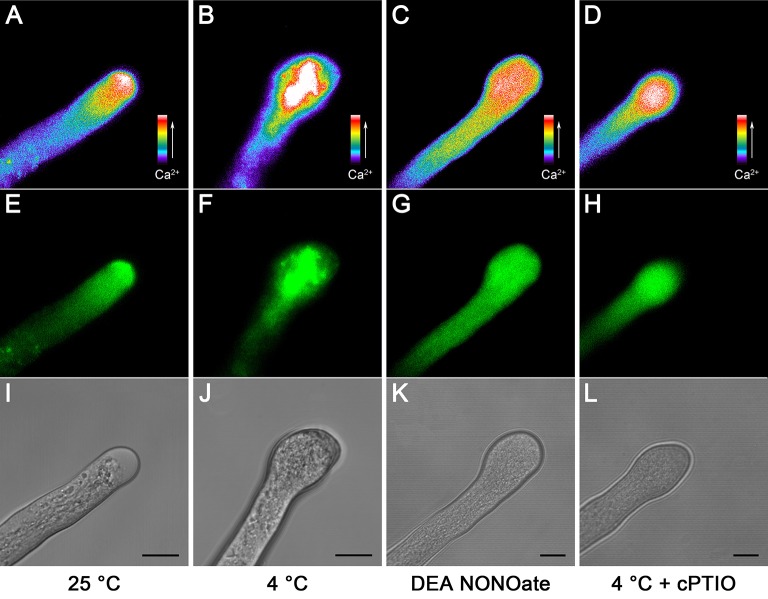
Changes in the tip-focused Ca2+ gradient in C. sinensis pollen tubes after treatment with cold stress or DEA NONOate. Pollen tubes were loaded with the fluorescent Ca2+ indicator Fluo-4/AM ester, and the fluorescence was detected using LSCM (488 nm excitation and 515 emission). The control pollen tubes exhibited the typical tip-focused cytoplasmic Ca2+ concentration gradient (A). The corresponding fluorescent image (E) and bright field image (I) are shown below. The pollen tubes that were treated with cold stress (B) or 25 μM DEA NONOate (C) showed the disrupted cytoplasmic Ca2+ gradient. The corresponding fluorescent images (F,G) and bright field images (J,K) are shown below. The effects of cold stress on the cytoplasmic Ca2+ gradient were weakened by 200 μM cPTIO (D). The corresponding fluorescent image (H) and bright field image (L) are shown. At least 20 pollen tubes were observed and photographed in each of three replicates, and one representative image per treatment was displayed. Bar = 10 μm.